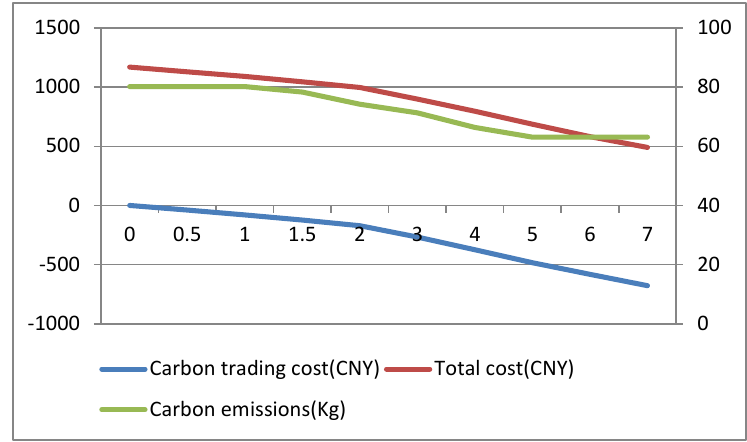
Figure 5. The changing trend of average customer satisfaction with the increase in carbon price under insufficient carbon quota.